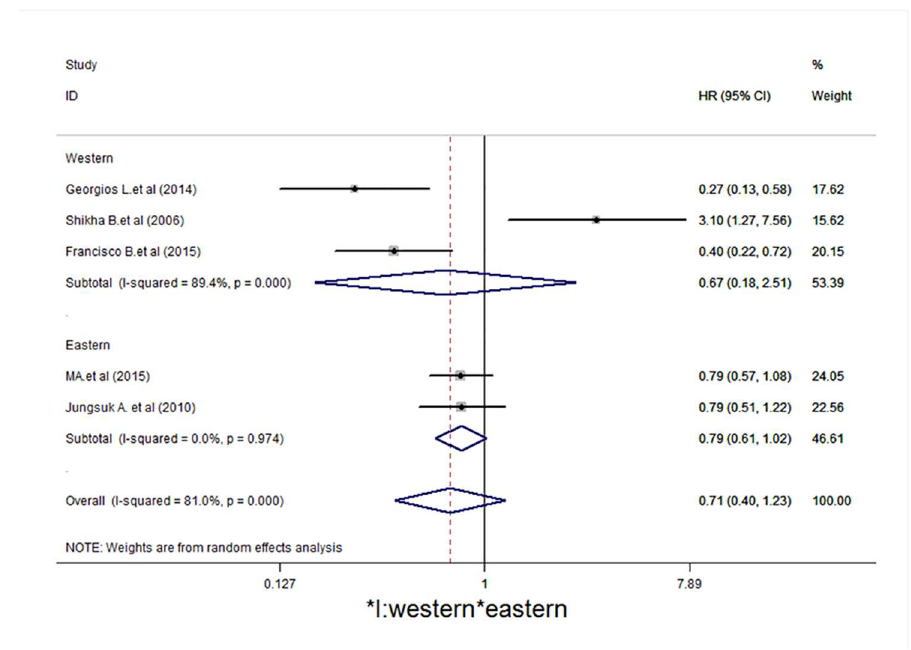
Fig 5. Subgroup analysis indicates that there is no statistical significance according to study region (Western and Eastern). Forest plot showingthe associationbetweenp-mTOR expressionand disease-free survival of breast cancer patients from the random-effects model.